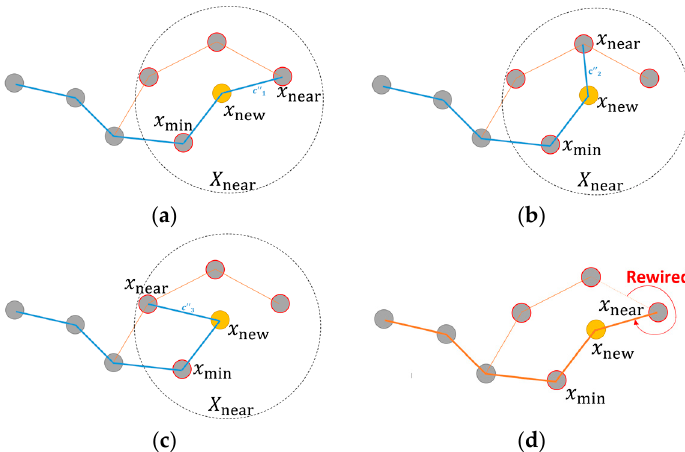
is lower when it is connected through the new vertex (cid:1876) (cid:2924)(cid:2915)(cid:2933) . If it is lower, then the edge Figure 7.